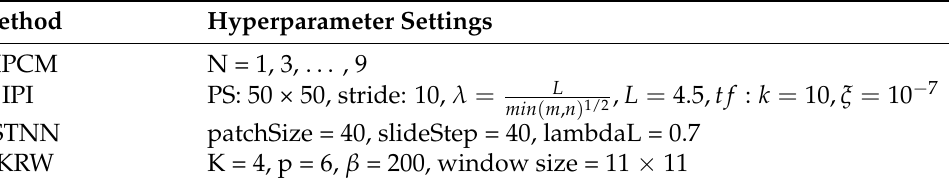
Table 3. Hyperparameter settings of model-driven